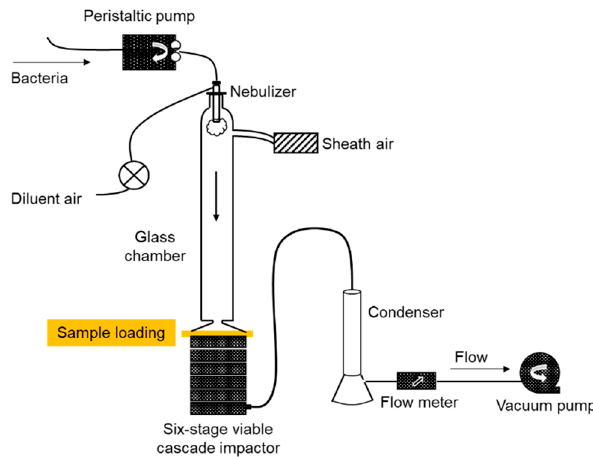
Figure 2. Illustration of bacterial filtration test.